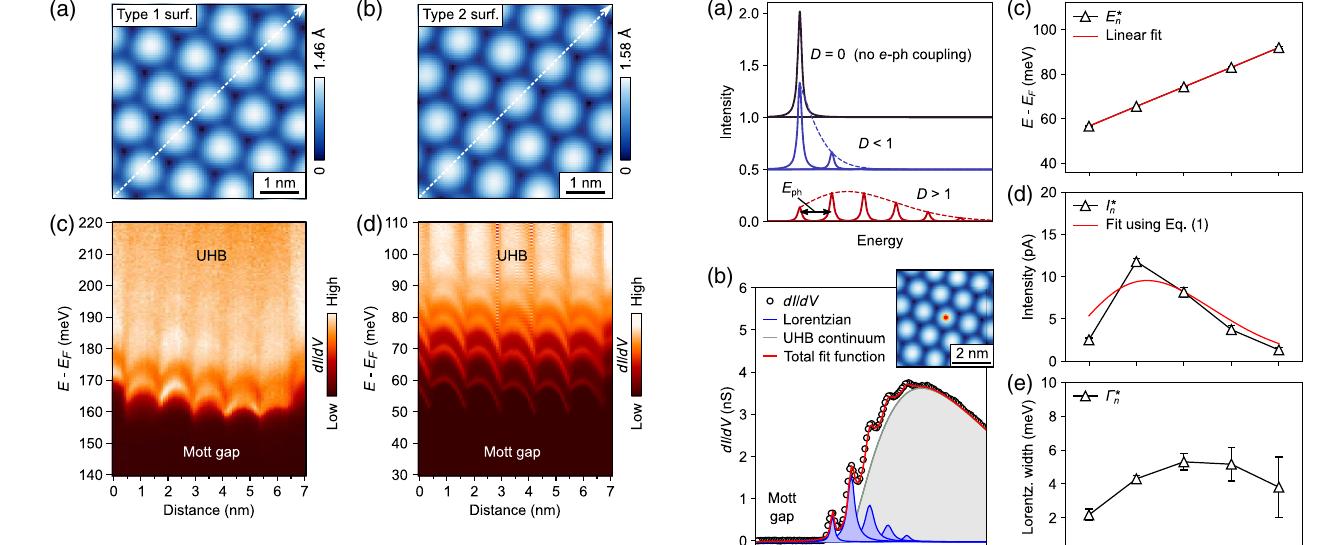
FIG. 2. Spectroscopic imaging at the UHB onset at type 1 and 2 surfaces. (a),(b) Constant-current topographs of each surface (setpoints V ¼ 0 . 25 V, I ¼ 1 nA, and V ¼ 0 . 11 V, I ¼ 0 . 44 nA, respectively). (c),(d) Spectroscopic line cuts taken along the white dashed lines shown in (a) and (b). Note that each energy range is chosen for suitability to each UHB onset energy. From here onward, this work focuses on the features observed at the type 2 surface.